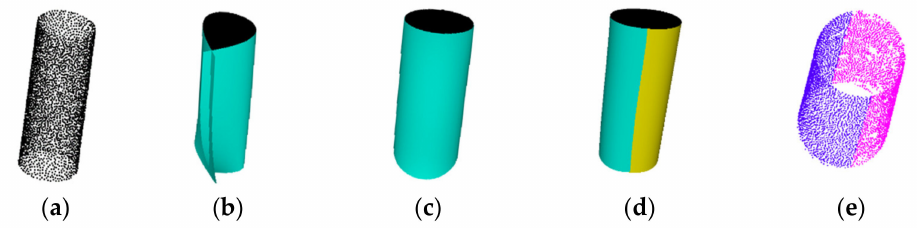
Figure 7. ( a ) Reconstructed 3D point cloud of a cylinder shape from multi-view 2D images; ( b ) re- constructed PDE surface using a single PDE model with 16 variables; ( c ) reconstructed PDE surface using a single PDE model with 64 variables; ( d ) reconstructed PDE surface using two PDE models with 16 variables; ( e ) segmented point cloud.